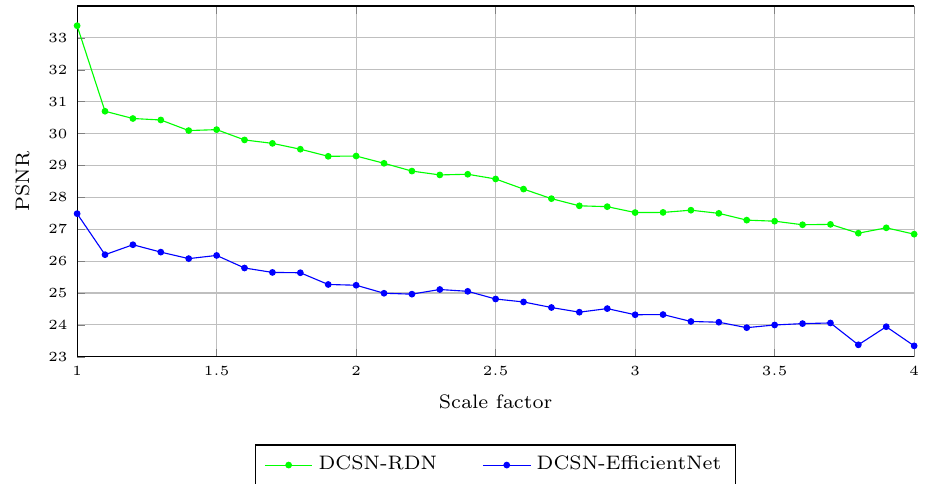
Figure 9. Average PSNR for different upsampling factors [ 1.1,1.2,1.3,...,3.7,3.8,3.9,4.0 ] using the proposed method on the missing depth value dataset [58].